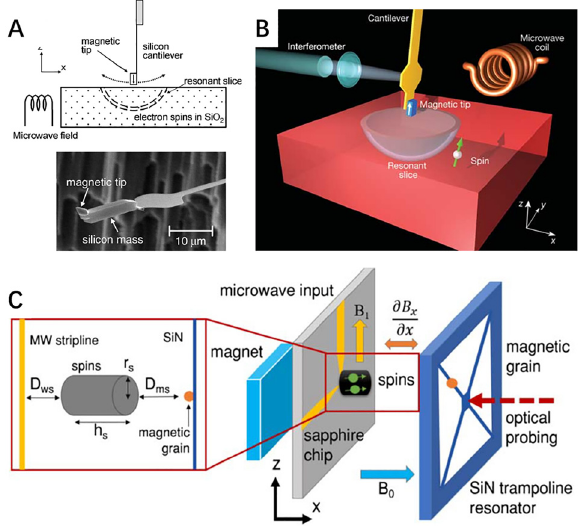
Figure 16: Magnetic force microscope using cavity